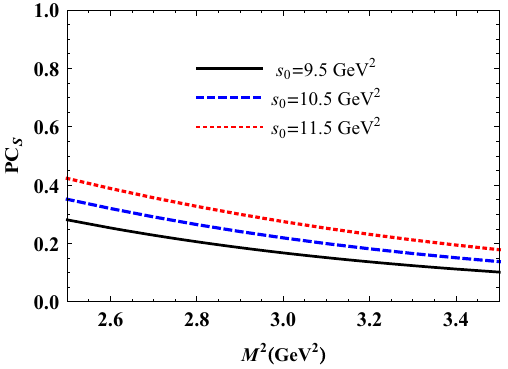
Fig. 6 The pole contribution in the case of the axial-vector tetraquark as a function of the Borel parameter M